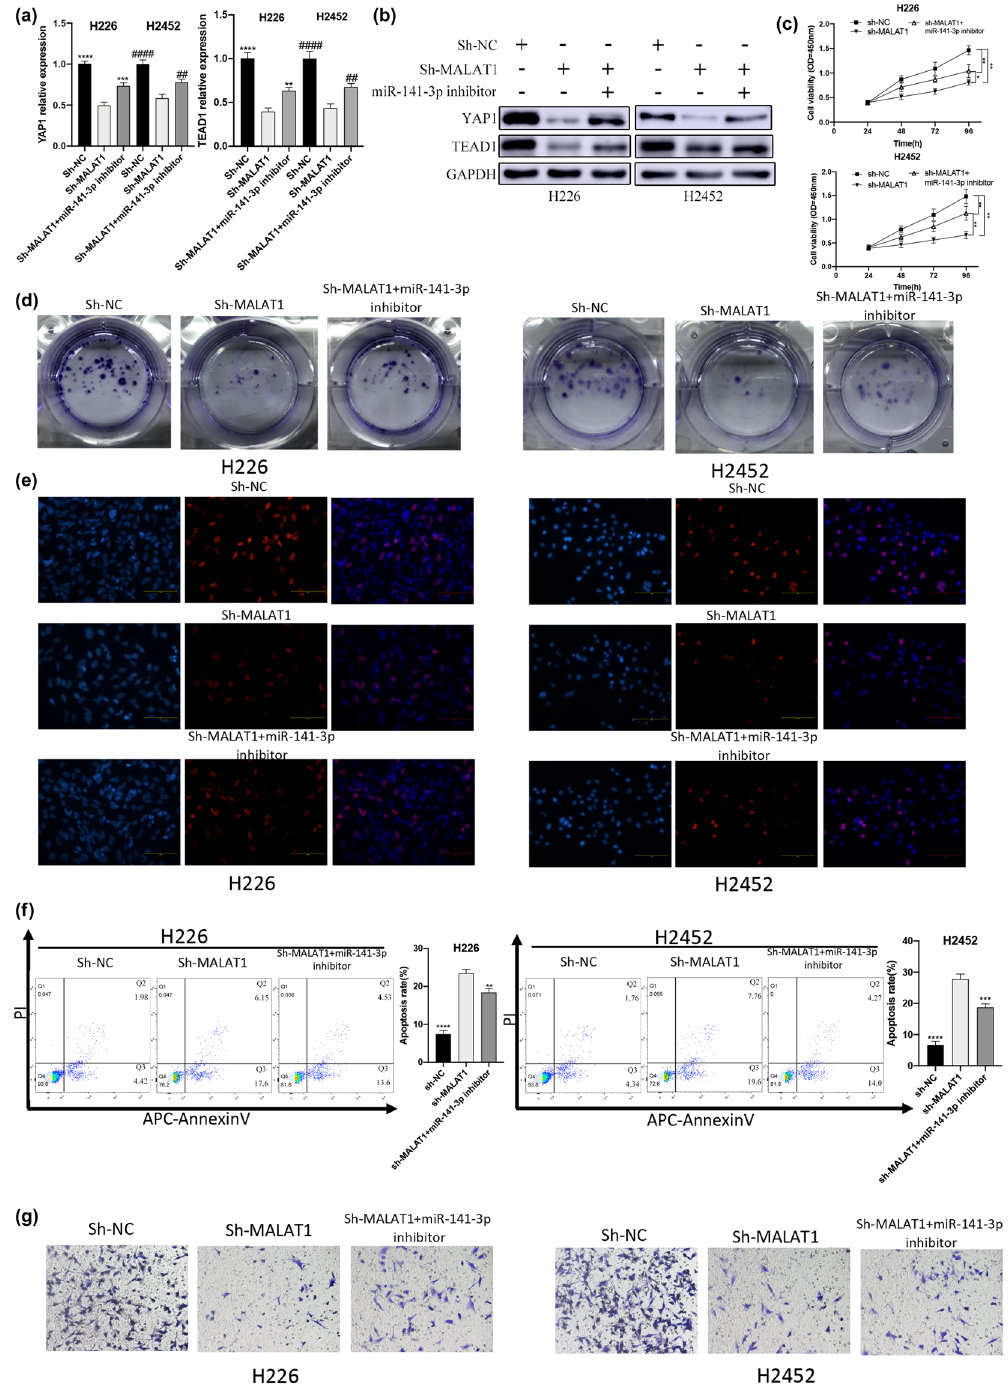
Figure 6: MALAT1 promotes the development ofMPM through the YAP1 - Hipposignaling pathwaymediatedbymiR - 141 - 3p. ( a ) TheRT - qPCRshowed that the decrease in mRNA levels of YAP1 and TEAD1 caused by knockdown of MALAT1 can be rescued by miR - 141 - 3p inhibitor ( ** P < 0.01, *** P < 0.001, **** P < 0.0001 vs Sh - MALAT1 [ H226 ] group; ## P < 0.01, #### P < 0.0001 vs Sh - MALAT1 [ H2452 ] group, one - way ANOVA and SNK - Q tests ) . ( b ) Western blotting revealed that the decrease in the expression levels of YAP1 and TEAD1 caused by knockdown of MALAT1 can be rescued by miR - 141 - 3p inhibitor. ( c ) CCK - 8 was used to detect the e ff ects of sh - MALAT1 and miR - 141 - 3p on the cell viability ( * P < 0.05, ** P < 0.01, t - test ) . ( d ) The in fl uences of sh - MALAT1 and miR - 141 - 3p on the cell proliferation were assessed by colony formation assay. ( e ) The e ff ects of sh - MALAT1 and miR - 141 - 3p on the cell proliferation were detected by EdU assay. ( f ) The in fl uences of sh - MALAT1 and miR - 141 - 3p on the cell apoptosis were determined by fl ow cytometry ( ** P < 0.01, *** P < 0.001, **** P < 0.0001 vs Sh - MALAT1 group, one - way ANOVA and SNK - Q tests ) . ( g ) The e ff ects of sh - MALAT1 and miR - 141 - 3p on the cell invasion were determined by Transwell invasion